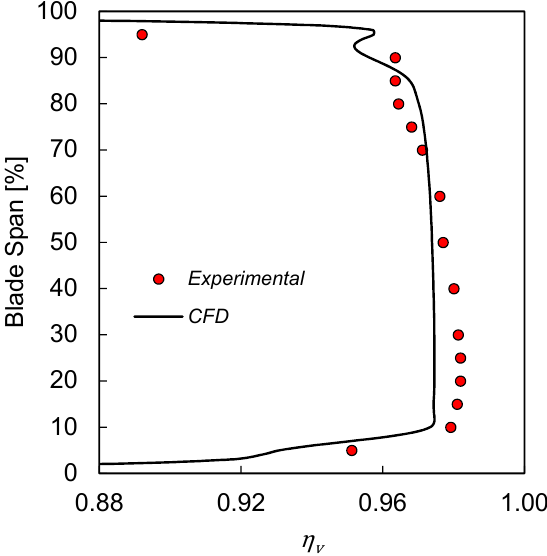
Figure 3. Comparison of isentropic Mach number at three different blade spans between experimental [23] and CFD val- ues.